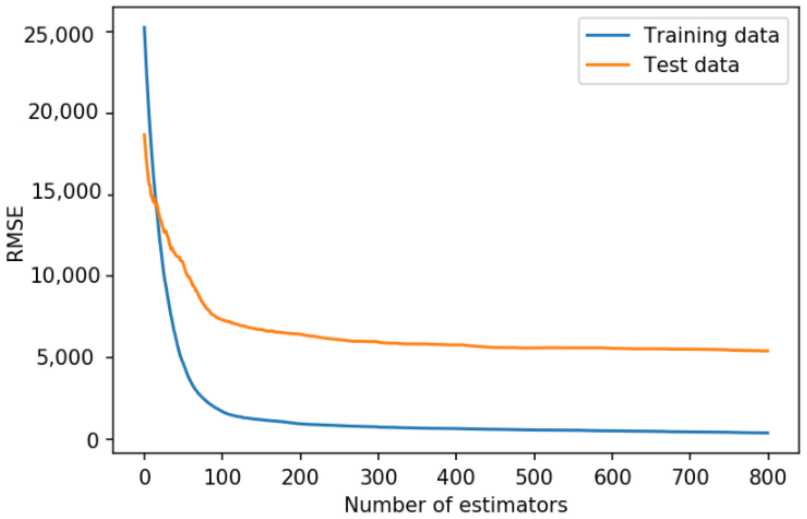
Figure 13. Variation of RMSE with number of estimators for GBR for 4° .